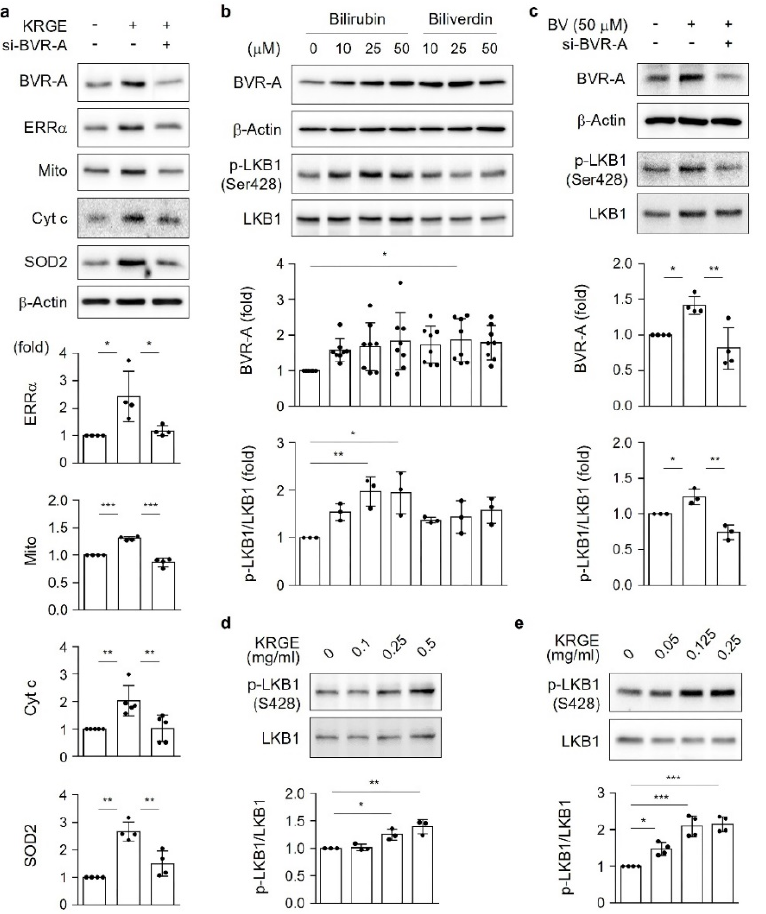
Figure 3. KRGE induces BVR-A/bilirubin-mediated LKB1 activation. ( a ) Astrocytes were transfected with control or the indicated siRNAs and subjected to 0.5 mg/mL KRGE for 24 h. Target protein levels in cell lysates were detected via Western blotting ( n = 4–5). ( b ) Astrocytes were incubated with 50 µM bilirubin or 50 µM biliverdin for 4 h. BVR-A ( n = 8), p-LKB ( n = 3), and LKB1 ( n = 3) protein levels were assessed by Western blotting. ( c ) Astrocytes were transfected with control or the indi- cated siRNAs and subjected to KRGE treatment. Target protein levels in whole-cell lysates were detected via Western blotting ( n = 3–4). ( d ) Cells were treated with various concentrations of KRGE